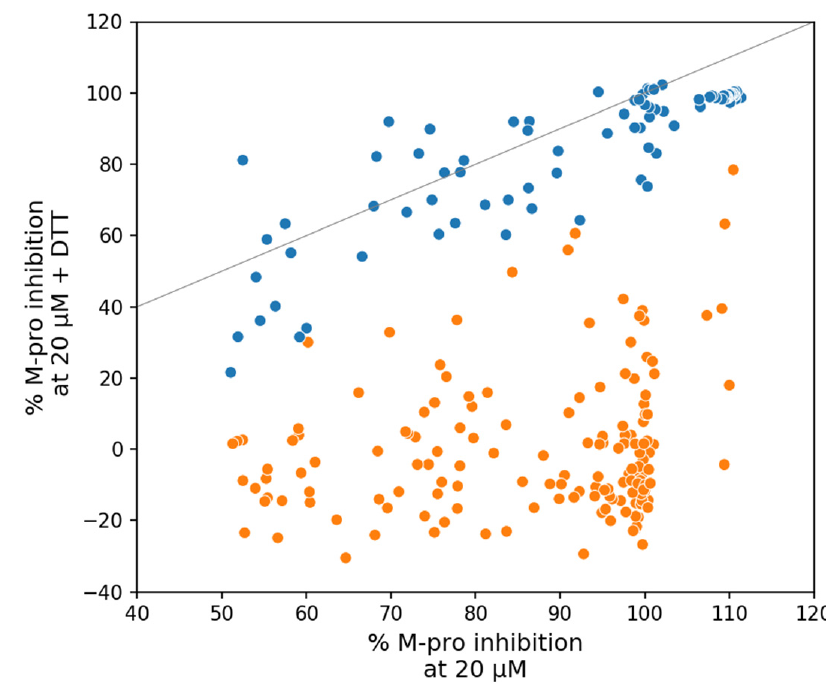
Figure 5. Effect of 1mM of DTT on M-pro inhibition in a group of 246 SARS-CoV-2 M-pro inhibitors [77]. A gray line represents the points where the presence of DTT does not affect the % of inhibition. Compounds far below the gray line are DTT-sensitive inhibitors and are colored orange. Compounds near the gray line are DTT insensitive inhibitors and are colored blue. The R 2 value of the insensitive compounds is 0.75 ( p = 1.1 × 10 − 27 ).